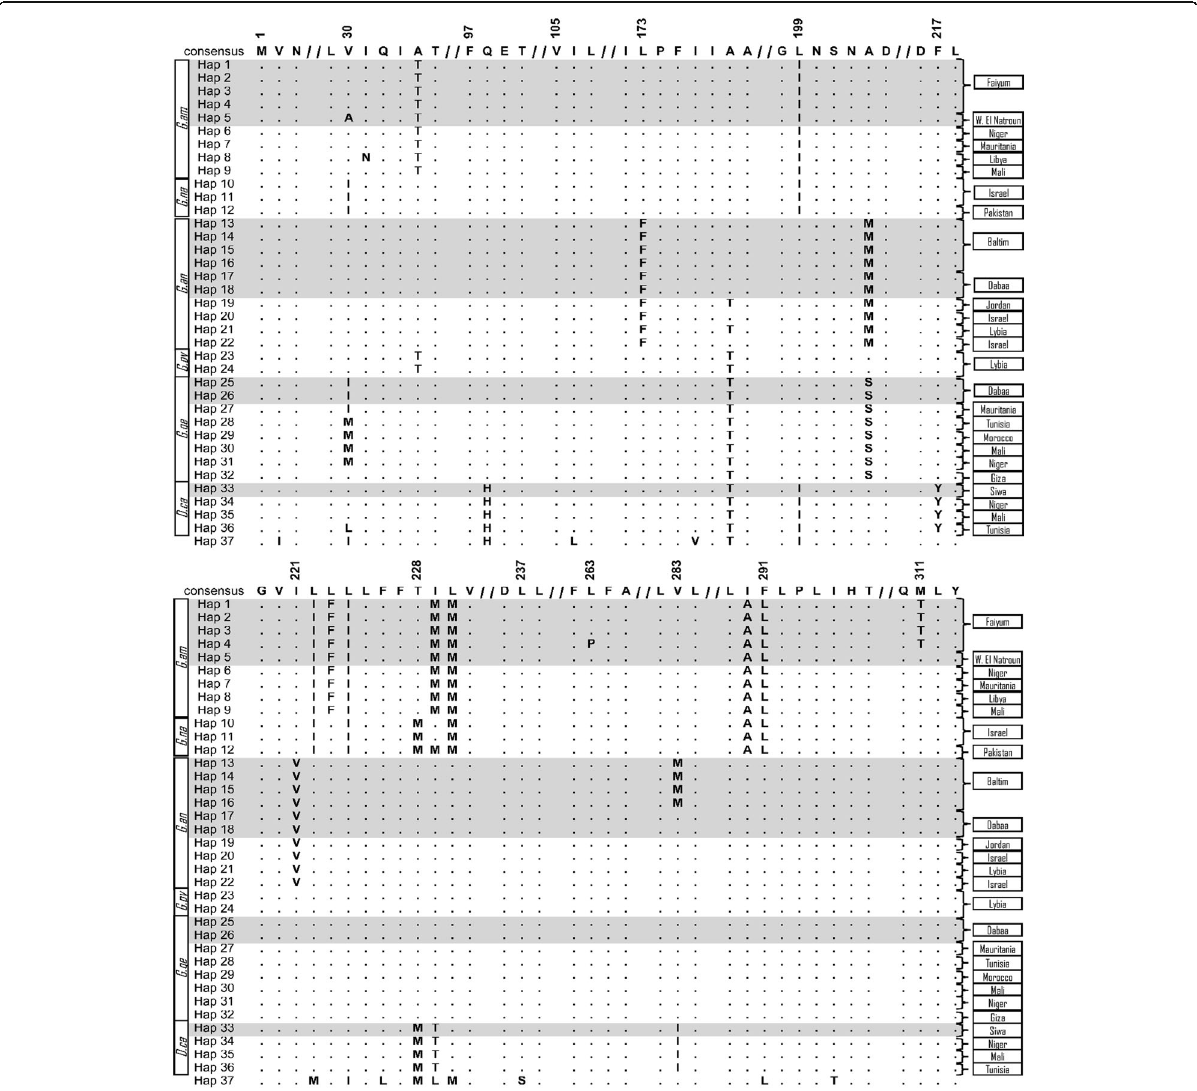
Fig. 1 Multiple sequence alignment of cytb protein residues haplotypes. “ Hap ” indicates haplotype; (.) represent the same amino acid as in the consensus sequence; (/ /) stands for sequences shared between all haplotypes. G.am: Gerbillus amoenus ; G.na: Gerbillus nanus ; G.an: Gerbillus andersoni ; G.py: Gerbillus pyramidum ; G.ge: Gerbillus gerbillus ; D.ca: Dipodillus campestris (also common as Gerbillus campestris ). Haplotypes with gray background are these from the current study compared to those from the